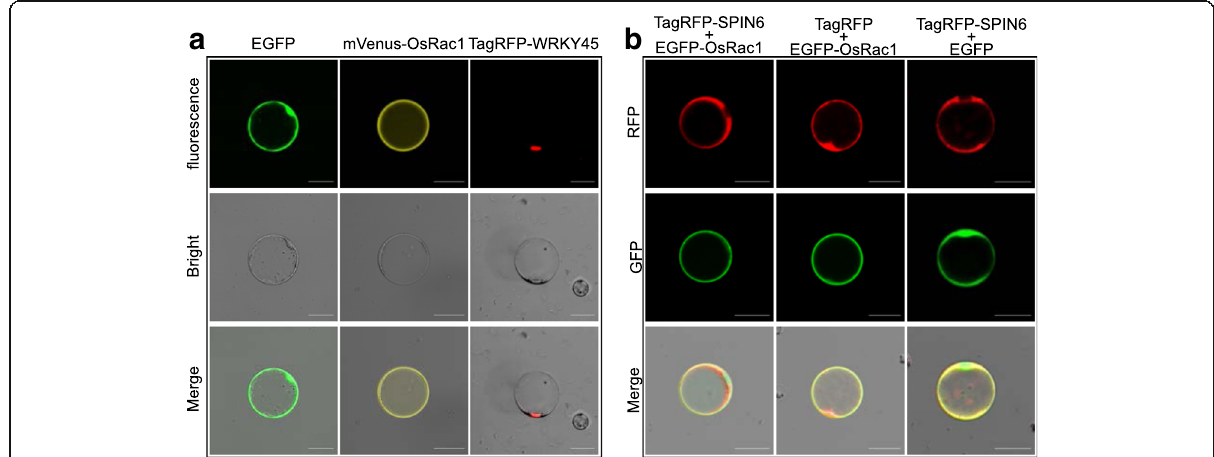
Fig. 2 Applications for protein localization in rice protoplasts. a Subcellular localization assay. Plasmids pRTVnGFP, pRTVnYFP-OsRac1, and pRTVnRFP-WRKY45 were used for subcellular localization assays. Bar=20 μ m. b Co-localization assay. Plasmids pRTVnGFP-OsRac1, pRTVnRFP-SPIN6, and the corresponding empty vectors were used for co-localization assays. Bar=20 μ